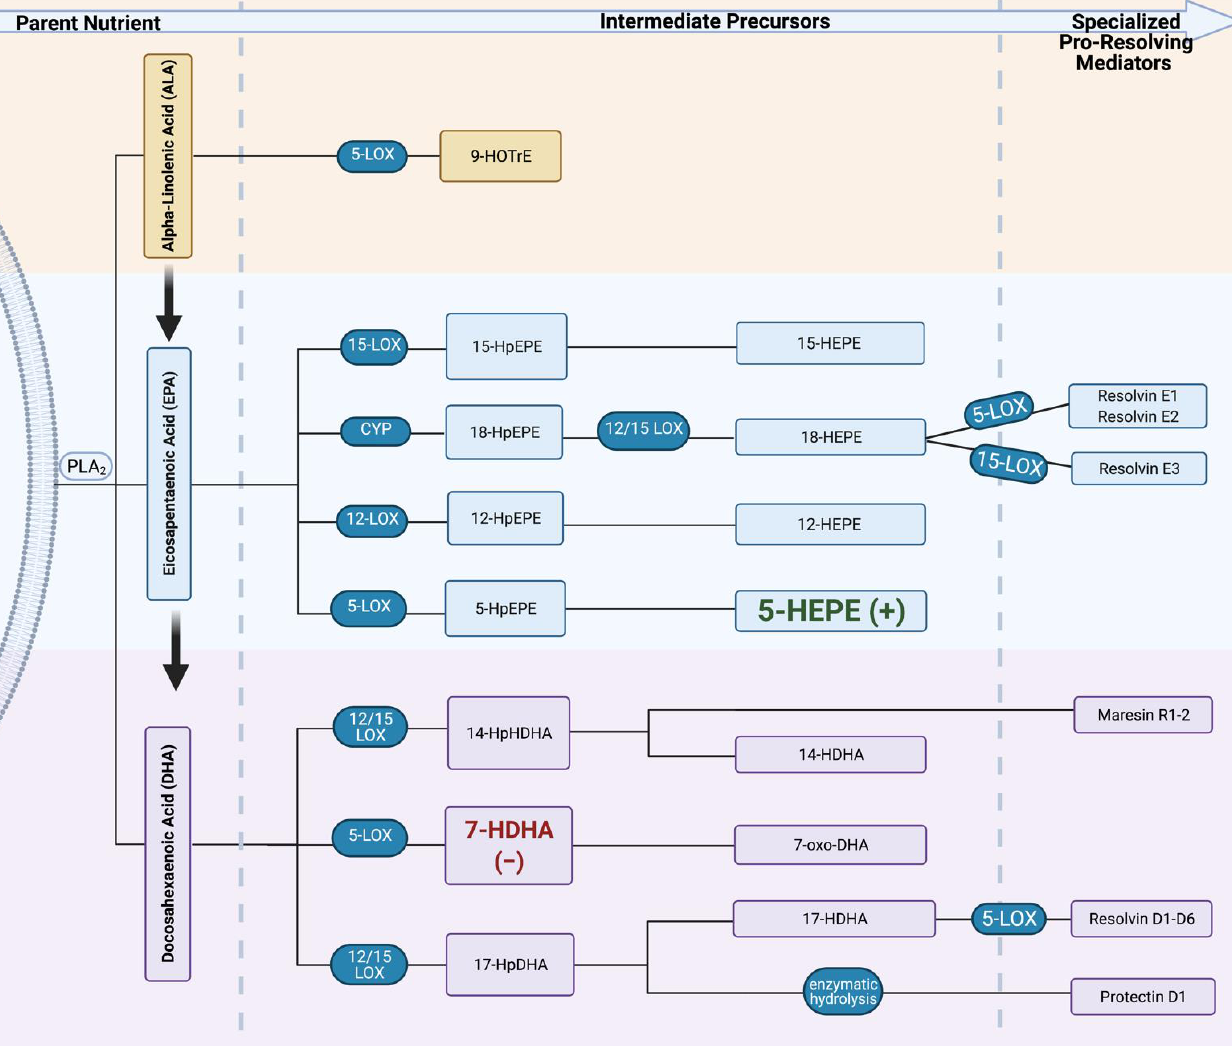
Figure 2. Lipoxygenase (LOX) enzymatic breakdown of n-3 PUFA. Omega-3 FAs are enzymatically cleaved by phospholipase A 2 (PLA 2 ) from the phospholipid bilayer. Parent n-3 FA can then interact with the same LOX enzymes that break down n-6 to be metabolized into oxylipins with less potent anti-inflammatory properties. Increases in cord 5-HEPE were predictive of an increase in birth length percentile. However, increases in maternal 7-HDHA were predictive of a decrease in birth weight percentile. Created with BioRender.com (30 Dec. 2021). (+), beta value was positive; (−), beta value was negative; HOTrE, hydroxyoctadecatrenoic acid; HpEPE, hydroxyeicosatetraenoic acid; HEPE, hydroxyeicosapentaenoic acid; HpHDHA, hydroxyperoxydocosahexaenoic acid; HDHA, hydroxydocosahexaenoic acid; oxo-DHA, oxo-docosahexaenoic acid.